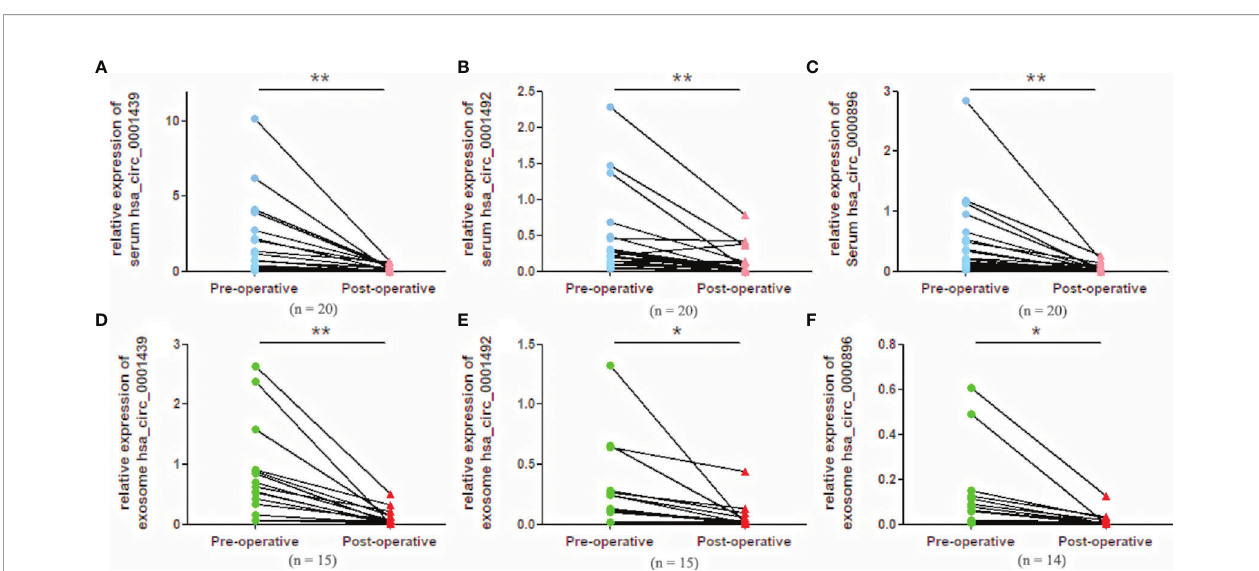
FIGURE 4 | Serum expression levels of hsa_circ_0001439 (A) , hsa_circ_0001492 (B) , and hsa_circ_0000896 (C) compared in preoperative and postoperative LUAD patients. Serum exosomal expression levels of hsa_circ_0001439 (D) , hsa_circ_0001492 (E) , and hsa_circ_0000896 (F) compared in preoperative and postoperative LUAD patients (n = 15). (*P < 0.05, **P <